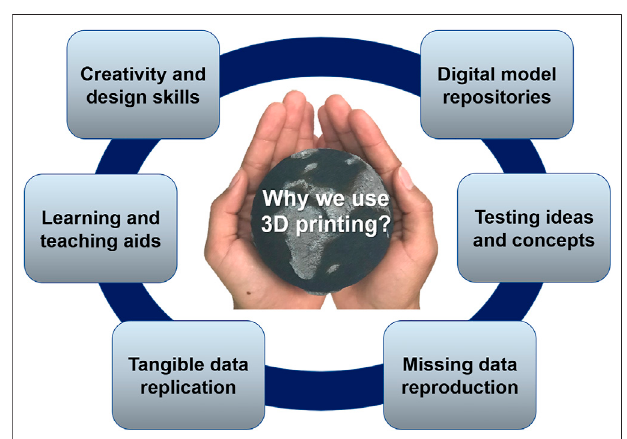
FIGURE1| Majorbene fi tsofusing3Dprintingingeosciences.Itisuseful fordevelopingcreativityanddesignskillsthrough3Dmodeling.3Dprintingisa convenienttoolfor rapidmanufacture oflearningand teachingaids.Any2D or 3D model can be replicated for a better communication, especially among non-specialists. Any digital data can be reproduced with 3D printing, even if the physical sample does not exist anymore. Research ideas and conceptscanberepeatedlytestedonthe3D-printedsamples.Alldatacanbe retrieved or repeated from the digital repositories, which include fi les of 3D- printed